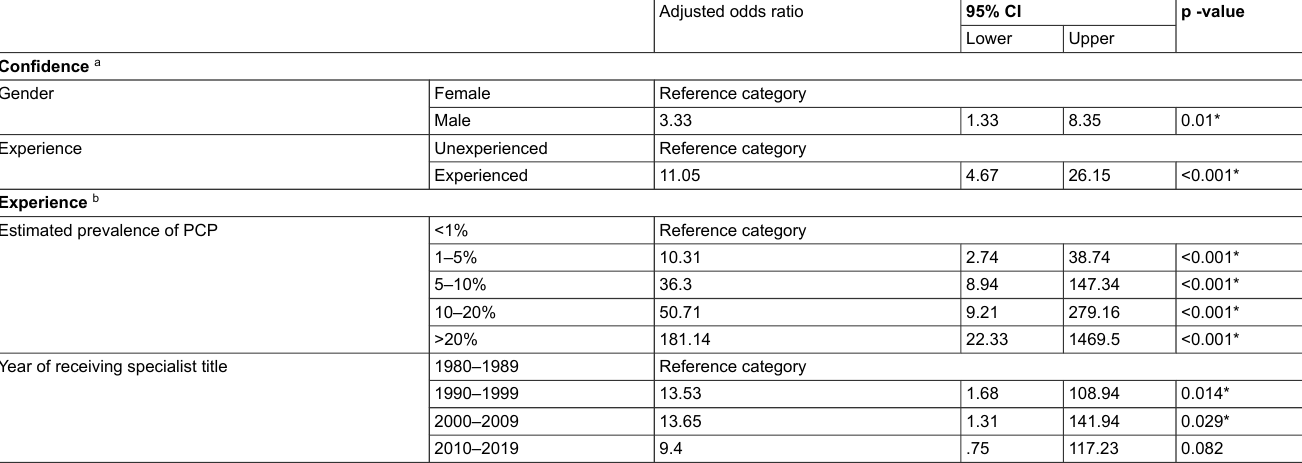
Table 3: Factors associated with confidence and experience in treating patients with paediatric chronic pain (PCP) (n =